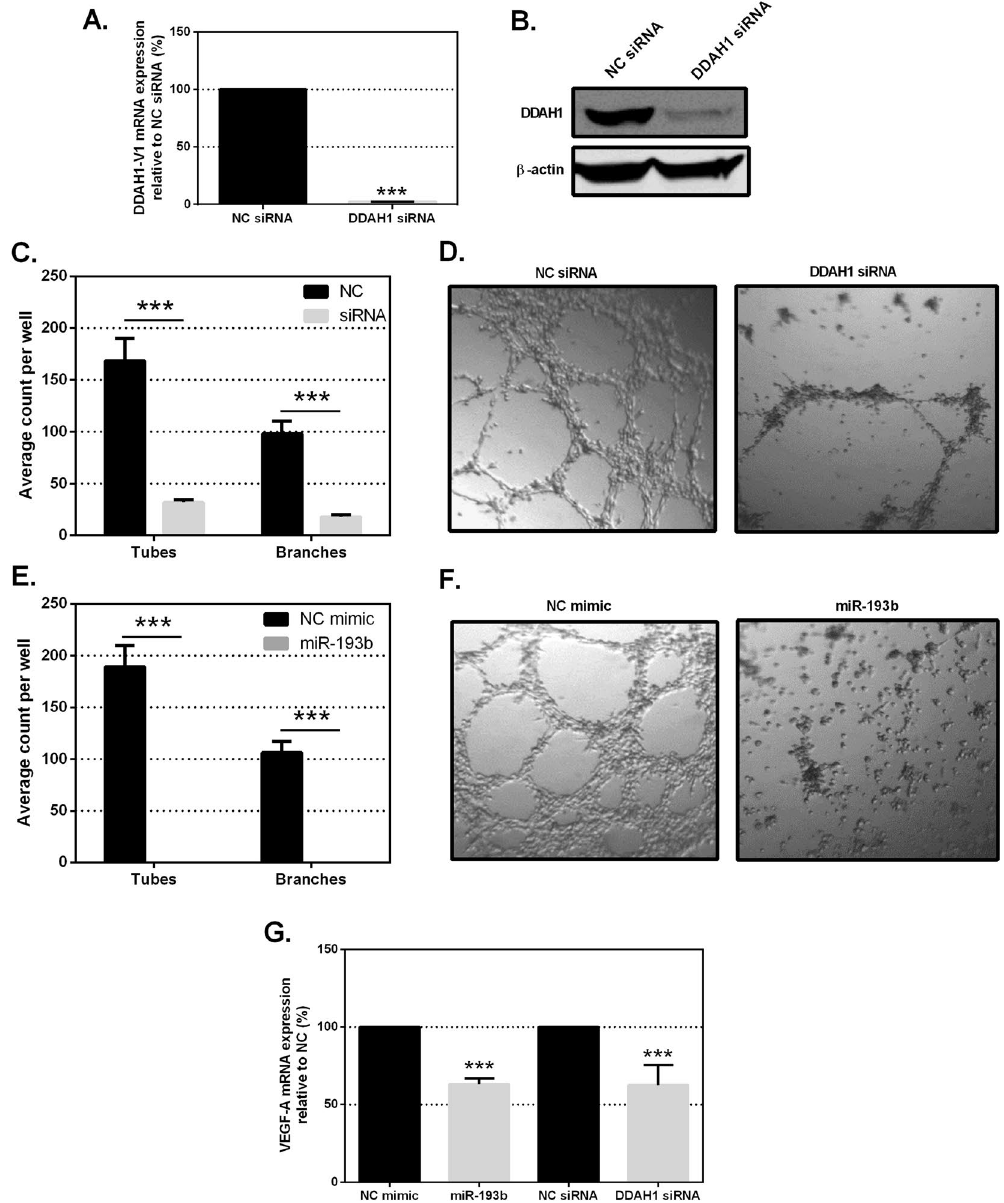
Figure 6. DDAH1 regulates the formation of tube-like structures by MDA-MB-231 cells on Matrigel. ( A , B ) Validation of DDAH1 gene knockdown following transfection with 30 nM DDAH1-targeting or control siRNA for 48 hr. DDAH1-V1 mRNA expression was normalised to 18S expression and is shown relative to control siRNA transfection, set to 100% ( A ). DDAH1 protein expression was assessed by western blotting ( B ). ( C ) MDA-MB-231 cells were transfected with 30 nM DDAH1-targeting siRNA or NC and the number of tubes and branches formed per well were quantified 24 hr after seeding on Matrigel. ( D ) Representative phase contrast images. ( E ) MDA-MB-231 cells were transfected with 30 nM miR-193b mimic or NC and the number of tubes and branches formed per well were quantified 24 hr after seeding on Matrigel. ( F ) Representative phase contrast images. Data shown are mean of three independent experiments performed in triplicate. ( G ) Expression of VEGF-A mRNA in MDA-MB-231 cells following transfection of 30 nM miR-193b mimic, DDAH1-targeting siRNA or appropriate controls. Expression was assessed 48 hr post-transfection and normalised to expression of 18S. Data are average of at least two independent experiments. Error bars represent SEM. *** p <